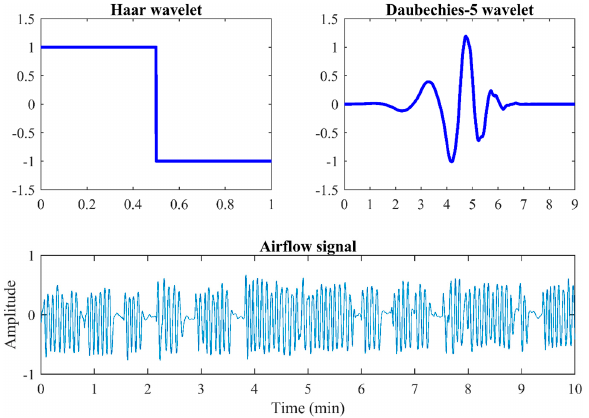
Figure 3. Mother wavelets Haar and Daubechies-5, and a 10-min segment of AF signal.